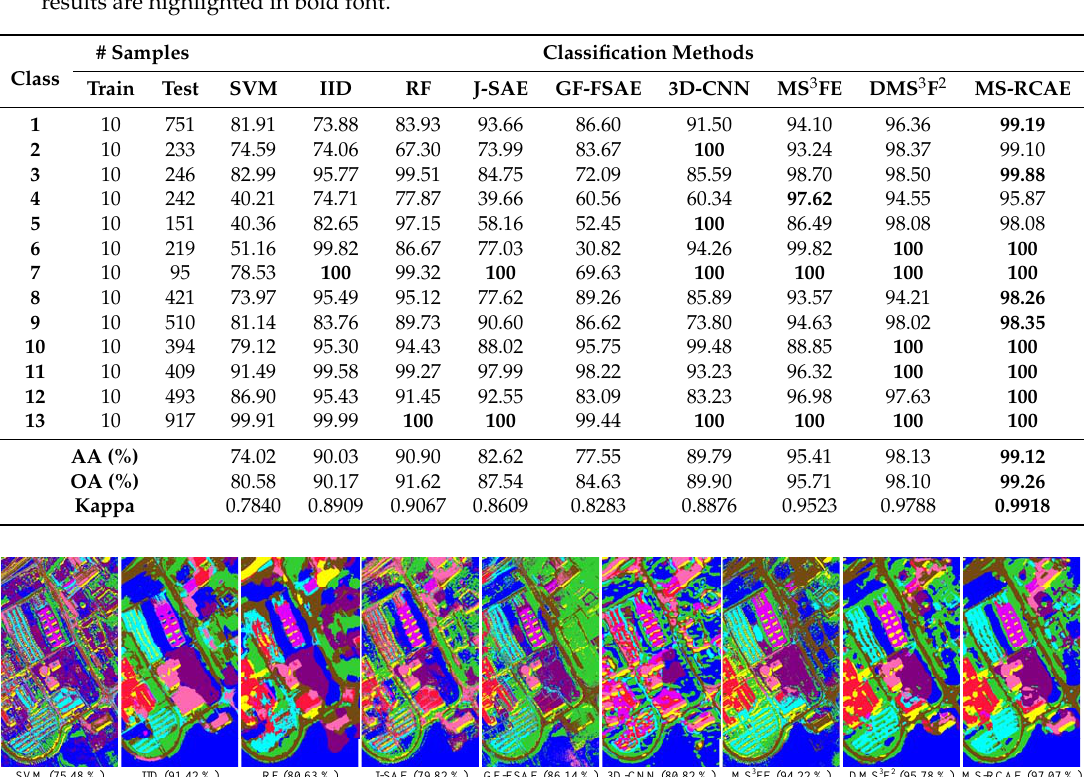
Table 4. Classification accuracies of the KSC dataset obtained by each comparison methods. The best results are highlighted in bold font.